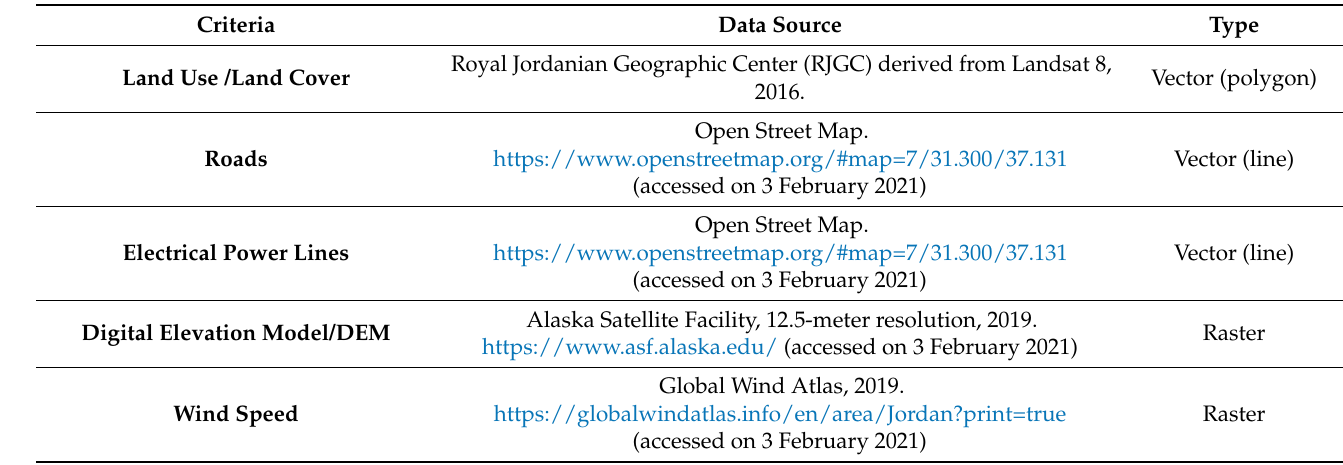
Table 2. Description of Criteria Used in This Study and Its Sources. Criteria Data Source Type Royal Jordanian Geographic Center (RJGC) derived from Landsat Land Use /Land Cover